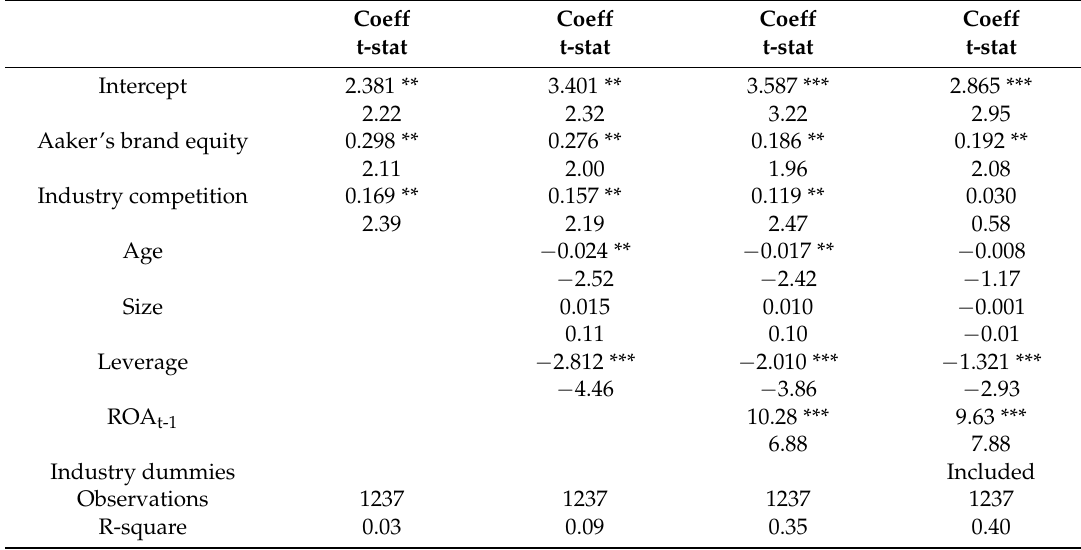
Table 5. Brand equity and performance, and